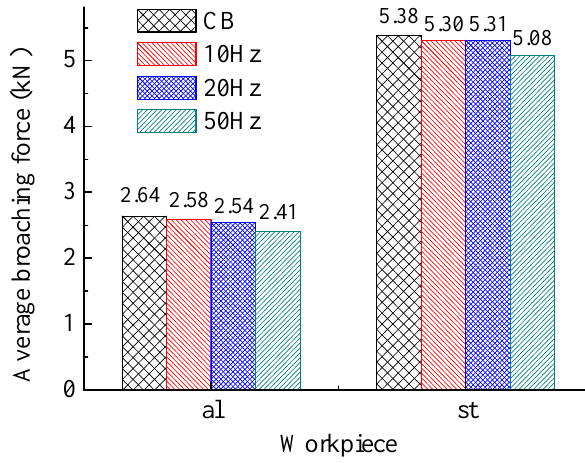
Figure 6. Average broaching forces of whole process.